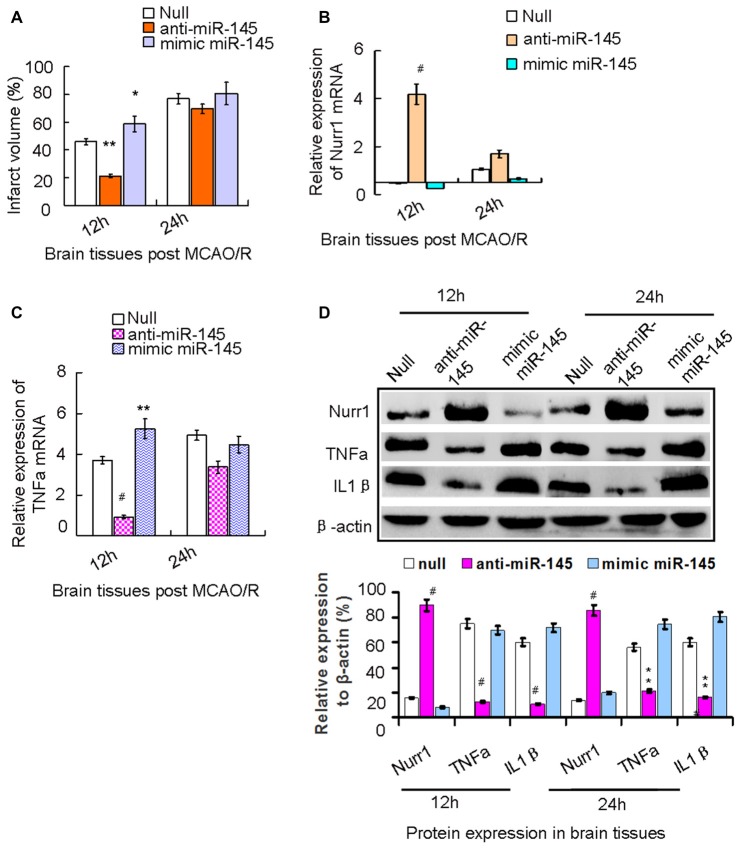
The axis signaling of miR-145-5p-Nurr1-TNF-α in acute MCAO/R model of rats by in vivo expriments. Infarct volume was plotted as the percentage of ipsilateral cerebral. (A) After 12 h of MCAO/R, administration of anti-miR-145-5p in vivo via ICV injection to ischemic rats immediately reduced Infarct volume by 39.05% (p < 0.01). While administration of miR-145-5p mimic increased infarct volume by 15.05% when compared to the null group (p < 0.05). However, these changes of infarct volume were not observed significantly at 24 h. (B) By RT-qPCR analysis, Nurr1 mRNA expression significantly increased in anti-miR-145-5p injection samples (p < 0.001) whereas decreased after administration of mimic miR-145-5p (p < 0.05). (C) In contrast, TNF-α mRNA expression significantly decreased in anti-miR-145-5p injection samples post 12 h of MCAO/R (p < 0.001) whereas significantly increased when administration of miR-145-5p mimic (p < 0.01). However, these significant changes of TNF-α mRNA expression were not observed in samples post 24 h of MCAO/R. (D) By western blot analysis, both TNF-α and IL1β expression levels were significantly suppressed by Nurr1 overexpression with administration of anti-miR-145-5p at 12 h and 24 h post-MCAO/R, and vice versa. *p < 0.05, **p < 0.01, #p < 0.001.